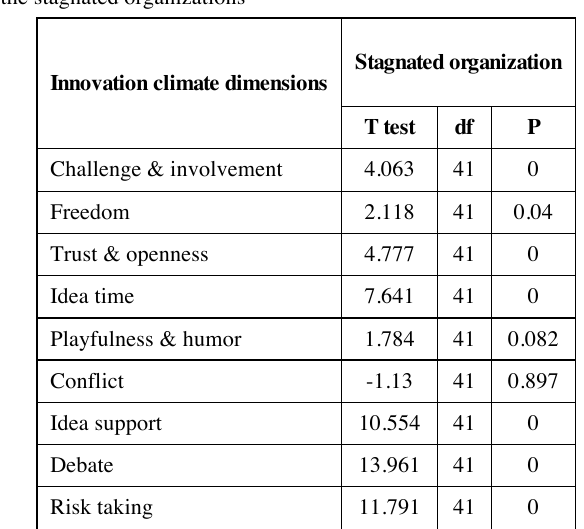
Table 7. T test values of comparing means of innovation climate dimensions between the company and the stagnated